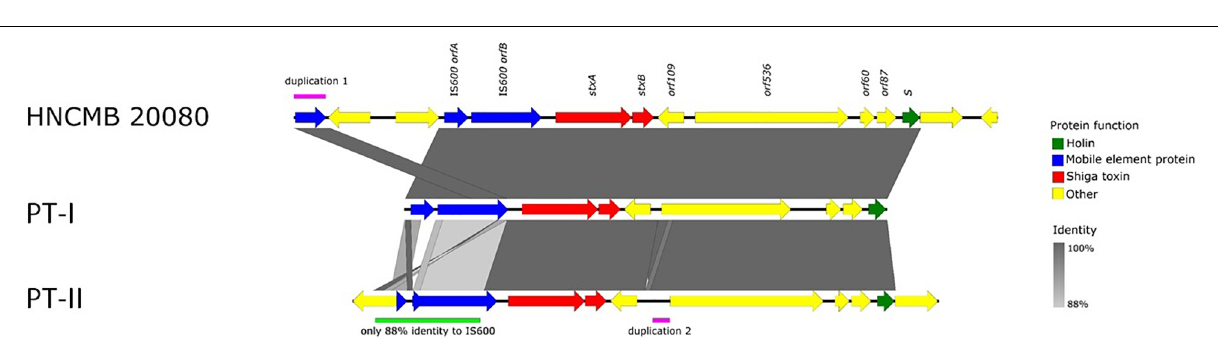
Frontiers in Microbiology |